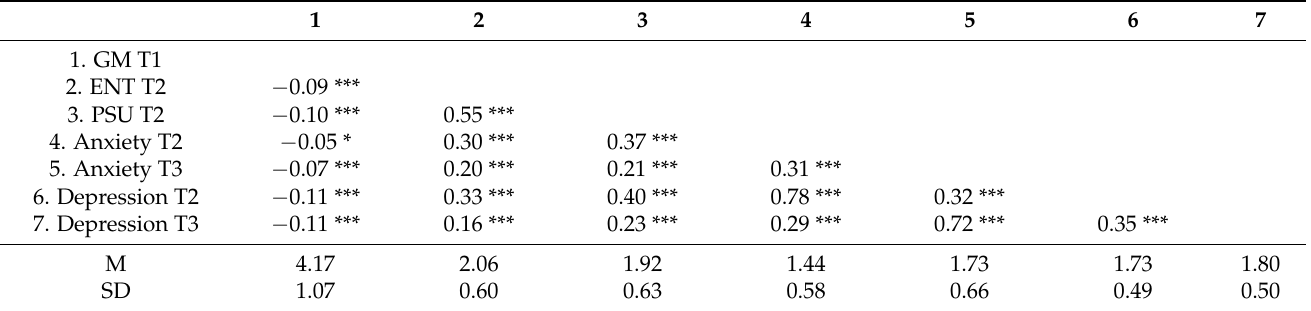
Table 2. Descriptive statistics and correlations among the research